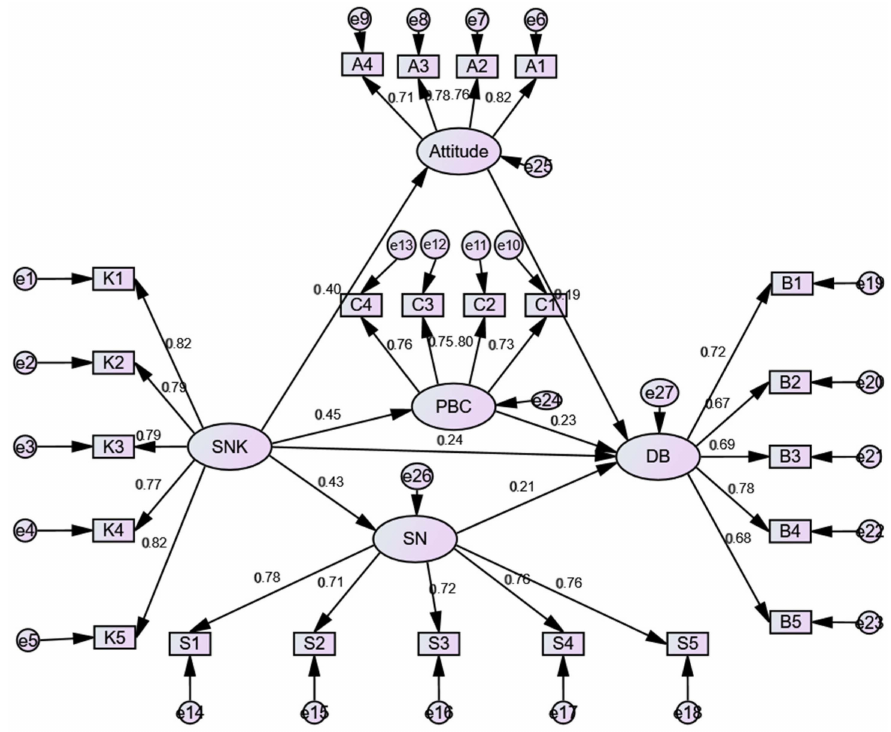
Figure 2. Standardized estimation of the correlation among knowledge, attitude, and behavior based on the final SEM